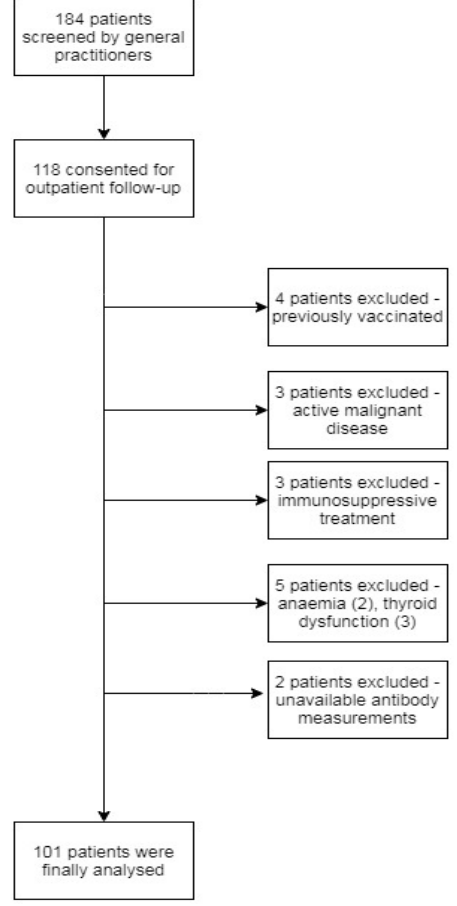
Figure 1. Patient selection for this prospective cohort study.